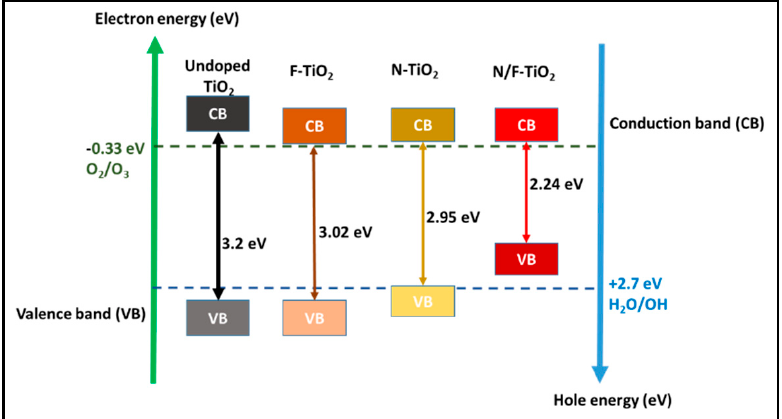
Figure 2. Schematic diagram of TiO 2 with different valence and conduction band levels; adapted from [49,53].